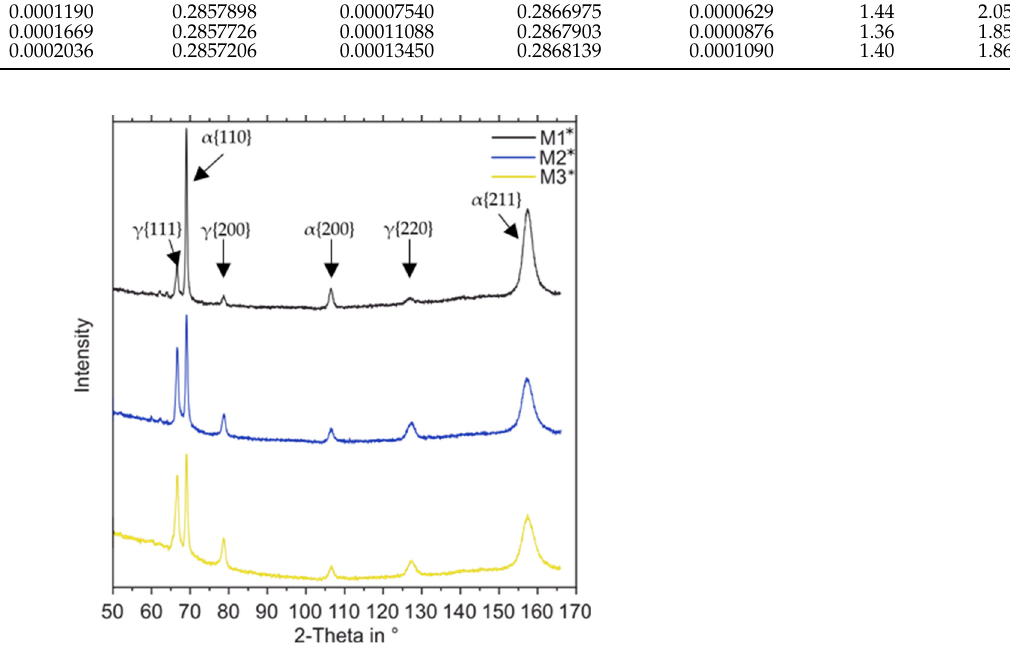
Figure 10 . Phase analysis (M1: black, M2: blue, M3: yellow). Figure 10. Phase analysis (M1: black, M2: blue, M3: yellow).